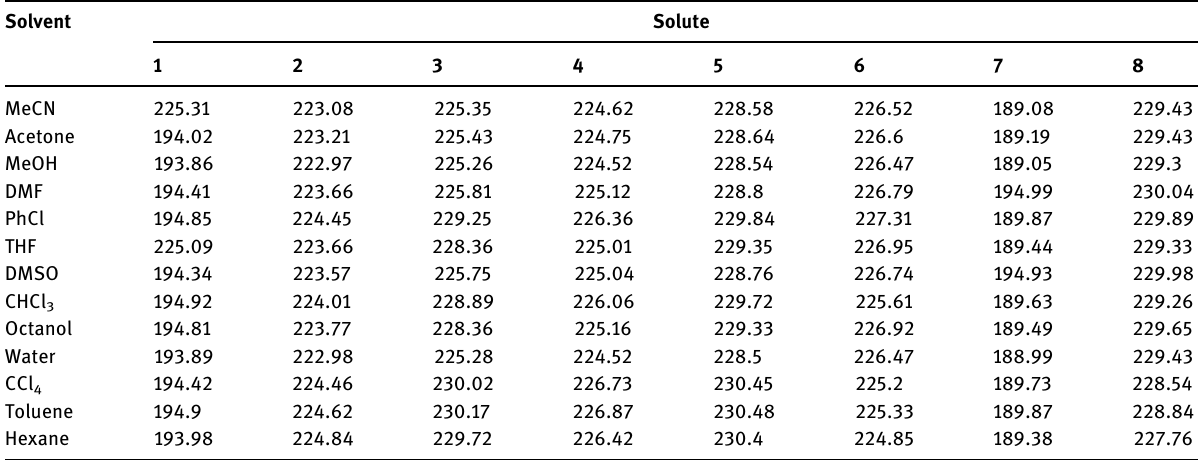
Table 9: Calculated values of λ max ( nm ) for azoles 1 – 8 at the WB97XD/6 - 311 ++ G ( 2d,3p ) //WB97XD/6 - 31G ( d,p ) level of theory using di ff erent solvents and PCM solvation